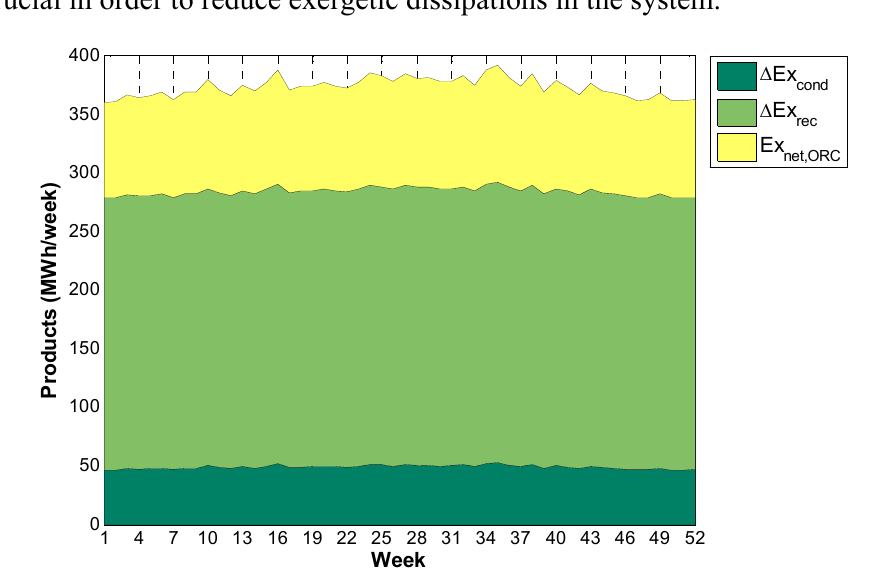
Figure 11. Weekly contribution of the different